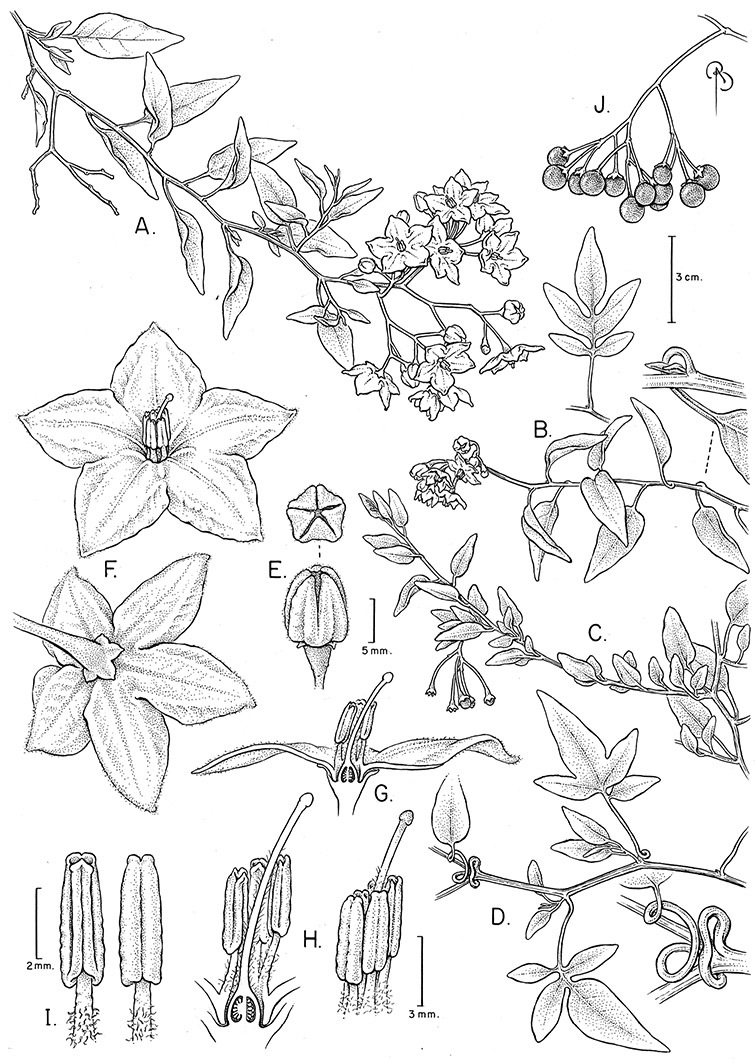
Solanum laxum Spreng. (A drawn from Nee 36730 and M.Nee photographs of plant in the field B drawn from Bohs & Nee 3191
C drawn from Hatschbach 22971
D drawn from Steyermark 53983
E–I drawn from plants cultivated in London). Illustration by Bobbi Angell.